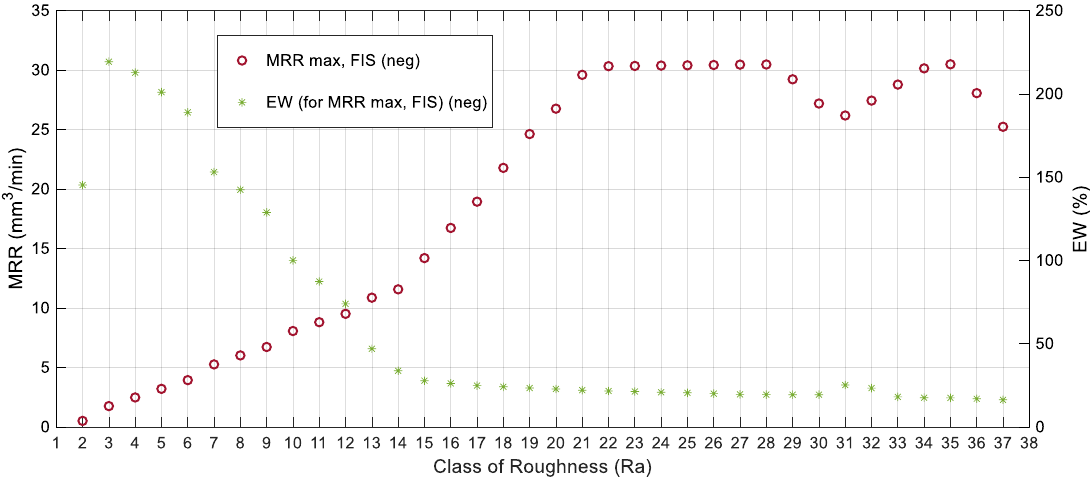
Figure 16. Values obtained from the technological table with the fuzzy inference system for the strategy of maximum removal rate using positive polarity.